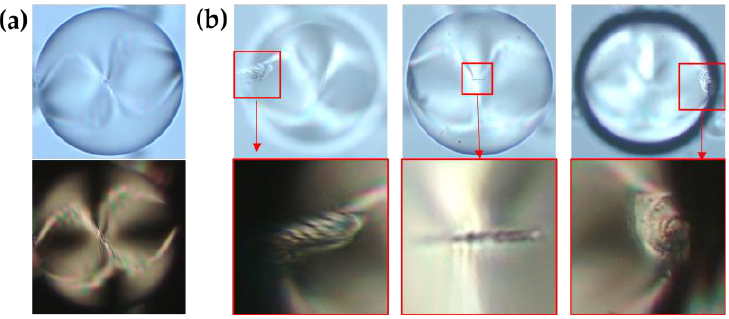
Figure 6. The impact of laser power on structural processing. ( a ) The CLC droplet with N = 6 contained three defect points. ( b ) Under laser irradiation, the injected water NDs self-assembled in the region with the defect point and arranged, along with the local director field, within the host CLC droplet. By adjusting the laser power, the injected NDs were organized into two different assemblies: twisting radial chains (65 µW) and quill-like structures (127 µW).